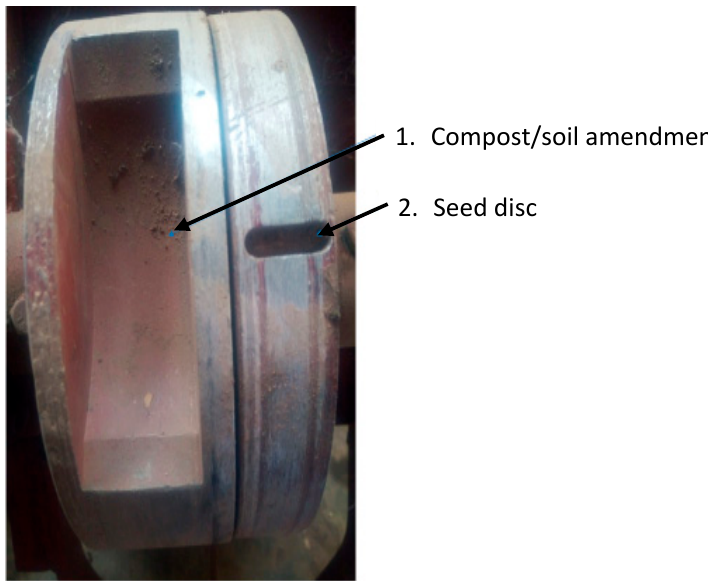
Figure 2. The disc to the left place the compost/soil amendments (1) and disc to the right applies seeds or a mixture of seed and fertilizer (2).